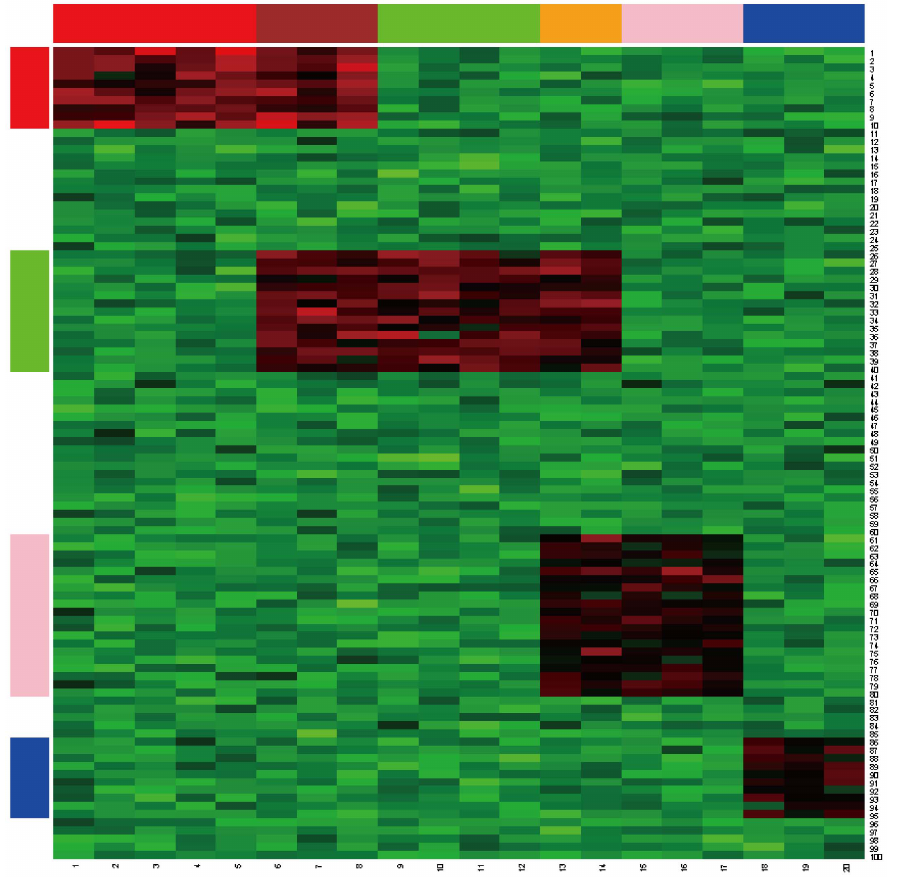
Figure 3. Heatmap of the original synthetic dataset biclustered in Figure 1. There are 4 biclusters colored as red, green, pink and blue in rows and columns; the brown and orange columns represent the overlapped columns of the biclusters.